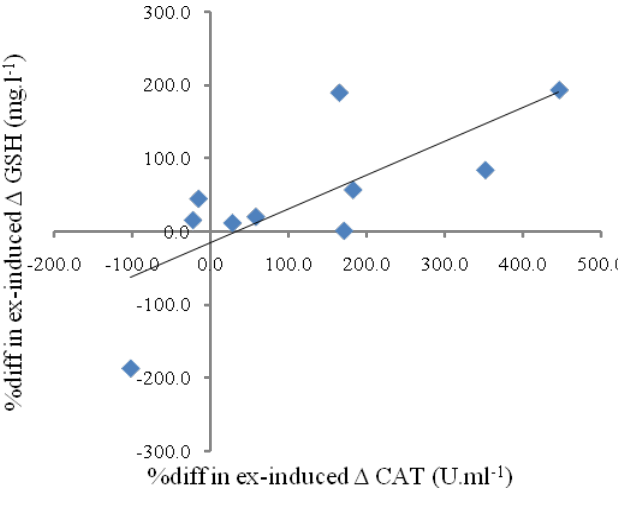
Figure 1. The linear relationship (r = 0.74, n = 10, p < 0.05) between differences in the exercise-in uc alt ration (Δ) in rum GSH an CAT r ulting from th y arly training program expressed as a percentage of pre-evaluation